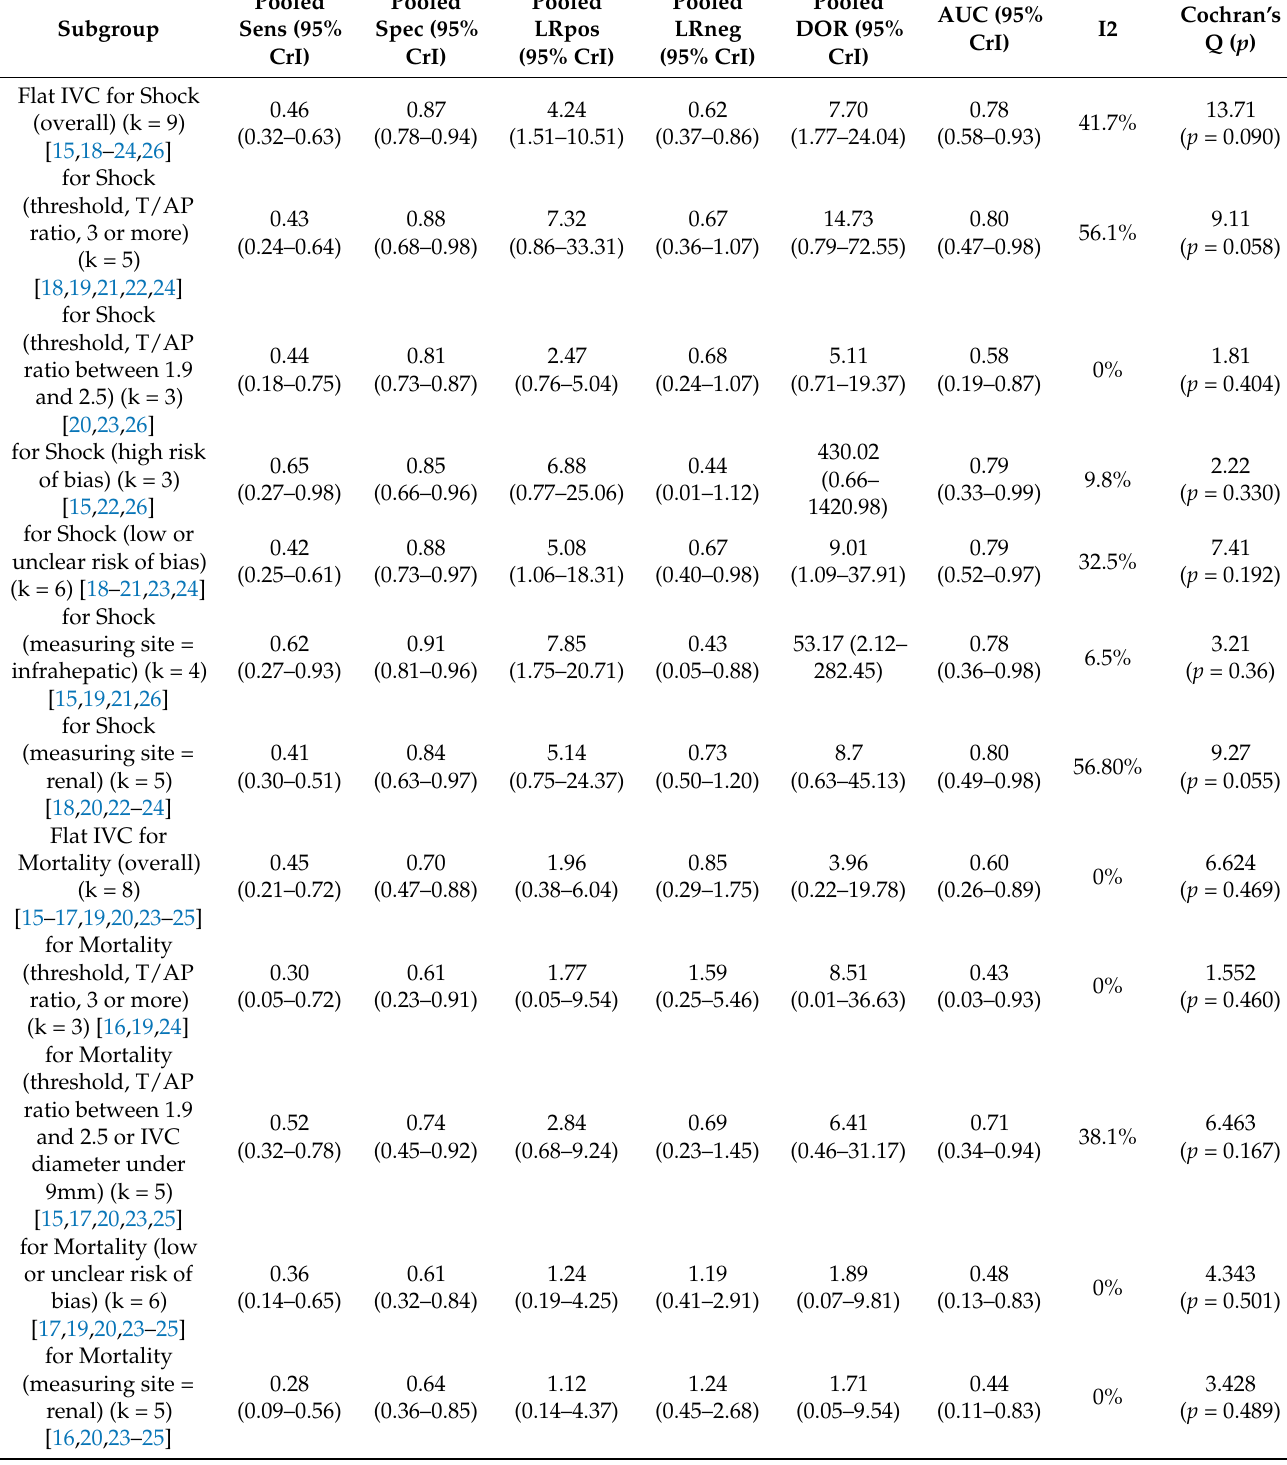
Table 2. Subgroup and sensitivity analysis of diagnostic test accuracy of flat